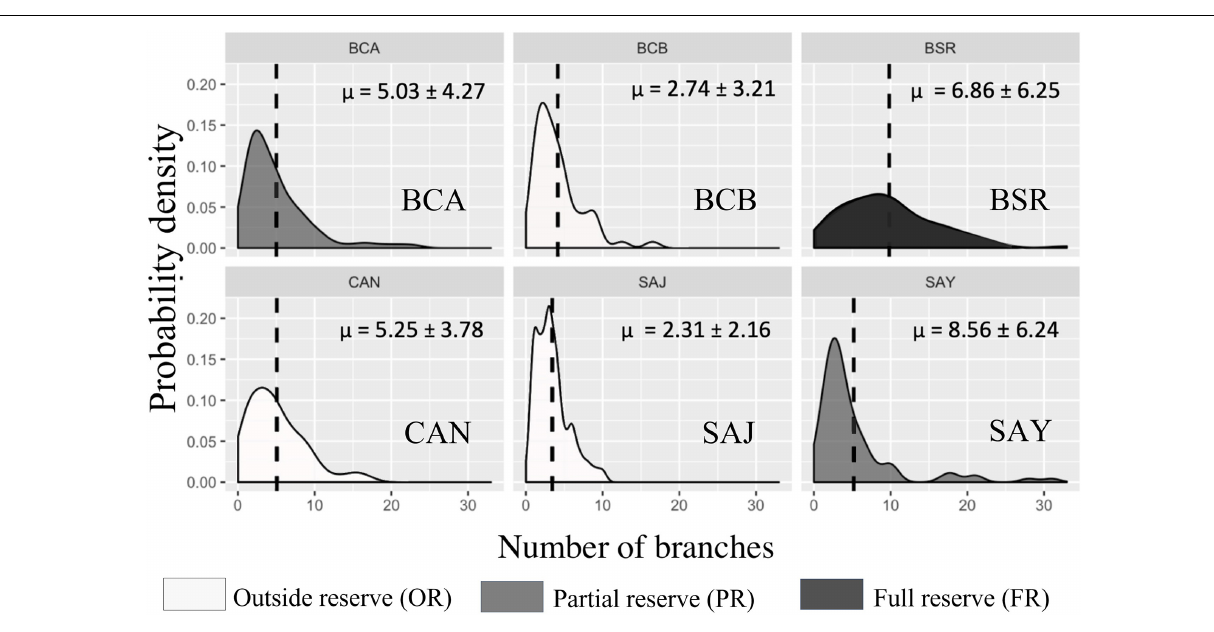
comparing full reserve vs. others levels. In 2012, the density functions ( Figure 8 ) showed an almost total overlap within the Cerbère-Banyuls reserve (partial reserve and outside reserve) for